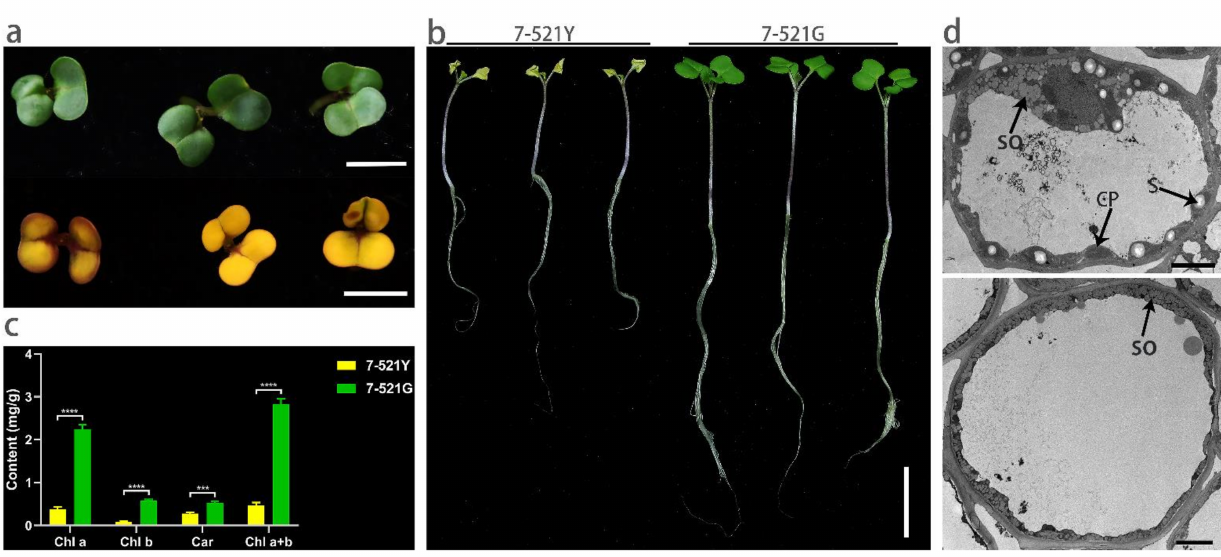
Figure 1. Phenotype characterization of 7-521Y. ( a ) Cotyledon phenotype of 7-521G (up) and 7-521Y (down) in the seedling stage (after 5 days of germination). ( b ) Whole plant phenotype of 7-521G (three on the right) and 7-521Y (three on the left) after germination for 12 days. ( c ) Chlorophyll a, chlorophyll b, carotenoid, and chlorophyll a+b content in 7-521Y and 7-521G. Car/Chl represents the carotenoid/chlorophyll ratio. Asterisks indicate a significant difference: *** p < 0.001 and **** p < 0.0001 (Student’s t -test). ( d ) Transmission electron microscope (TEM) micrographs of the cotyledons from 7-521G (up) and the mutant 7-521Y (down). Black arrows point to different structures in the cell. S—starch grains, CP—chloroplast, and SO—seed oil. Bars: ( a ) 5 mm; ( b ) 2 cm; ( d ) 5 µ